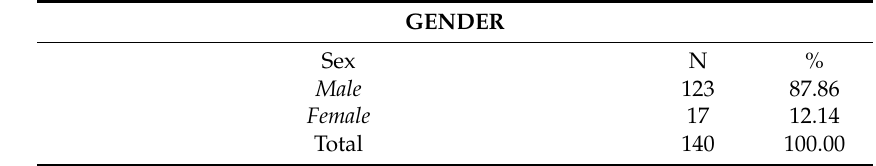
Table 5. Sample composition: main socio-economic and demographic